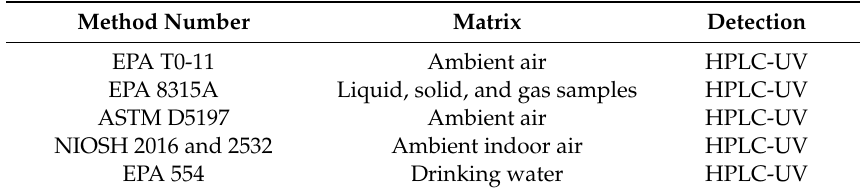
Table 1. DNPH derivatization and HPLC-UV analysis of carbonyl compounds for environmental